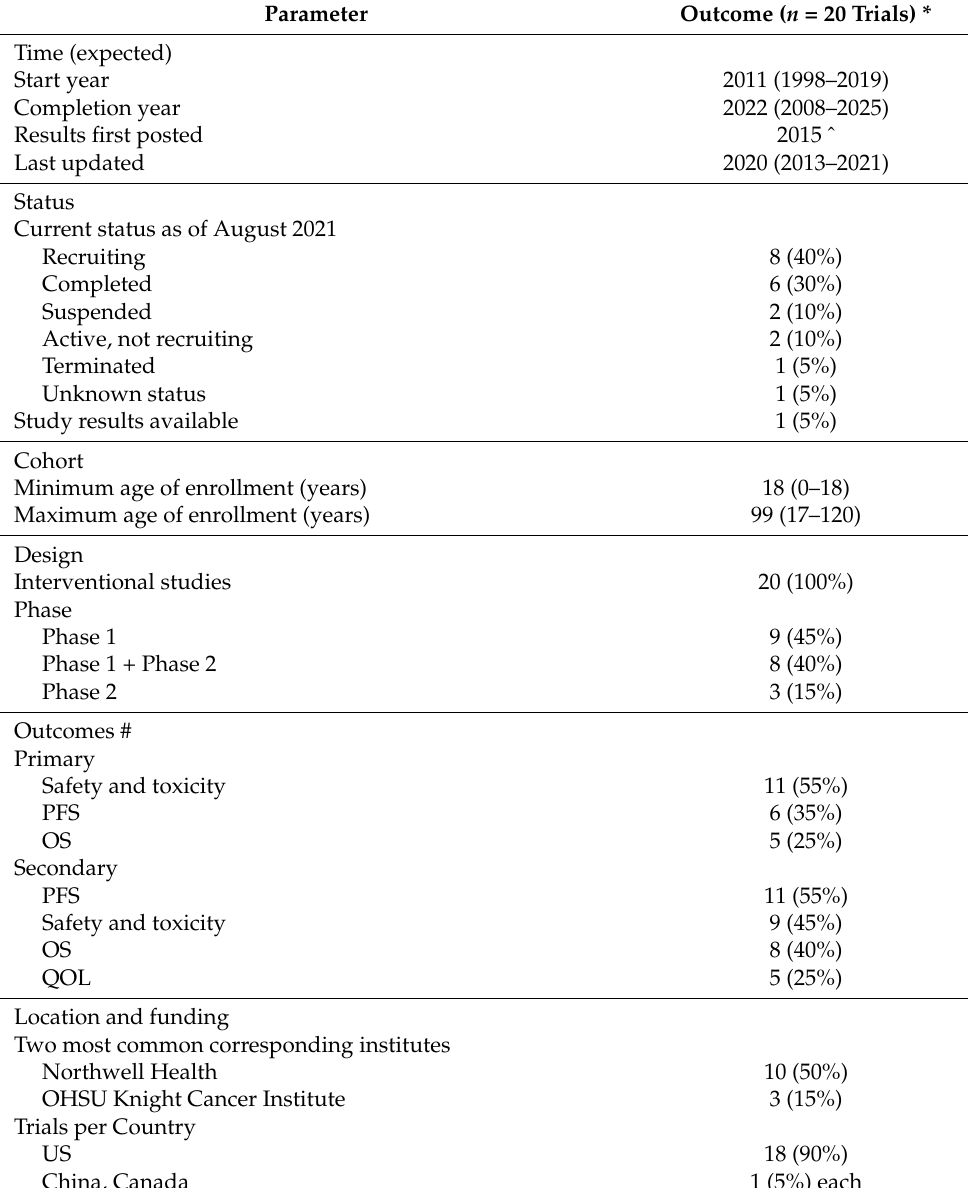
Table 2. Summary of clinical trial